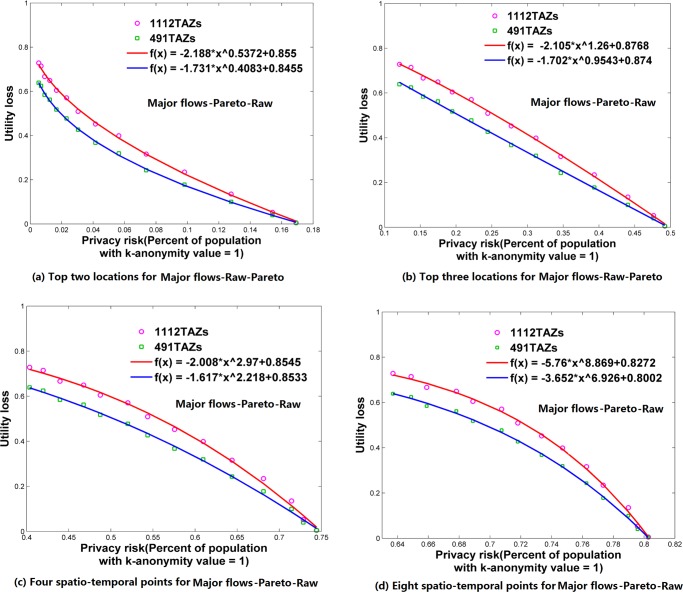
Relationships between privacy risk and data utility using Major flows-Pareto-Raw.(a) Top two locations. (b) Top three locations. (c) Four spatio-temporal points. (d) Eight spatio-temporal points.